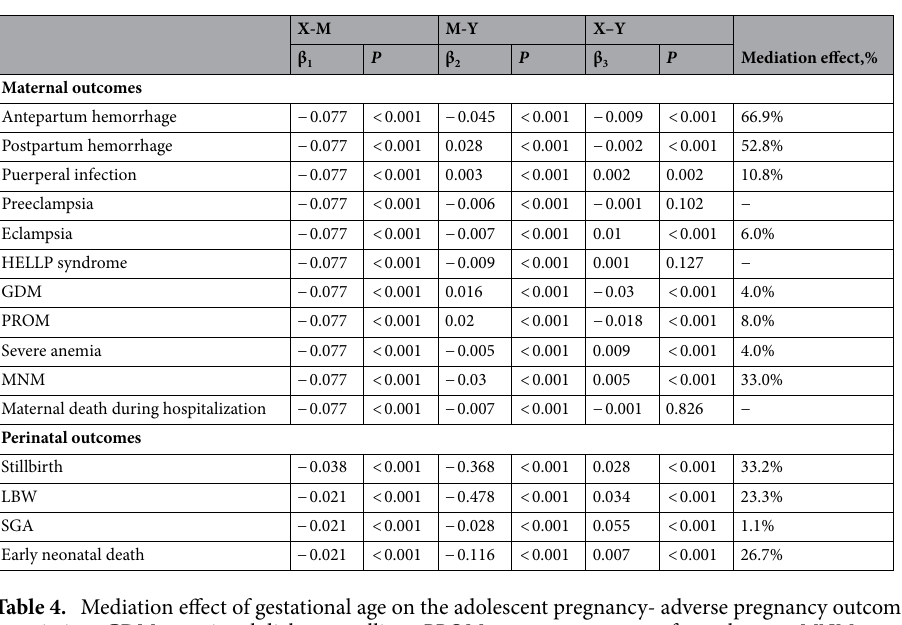
Table 4. Mediation effect of gestational age on the adolescent pregnancy- adverse pregnancy outcome association. GDM gestational diabetes mellitus, PROM premature rupture of membranes, MNM maternal near miss, LBW low birth weight, SGA small-for-gestation-age.